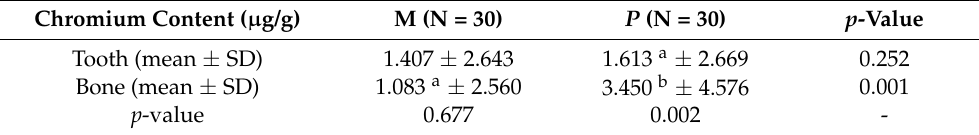
Table 15. Chromium content in tested samples taken from patients differing in place of residence.